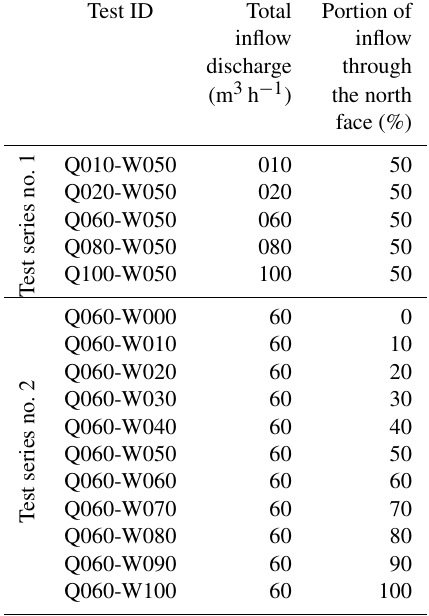
Table 1. Test series dedicated to testing the influence of the total inflow of the inflow partition between the west and north faces. Test ID Total Portion of inflow inflow